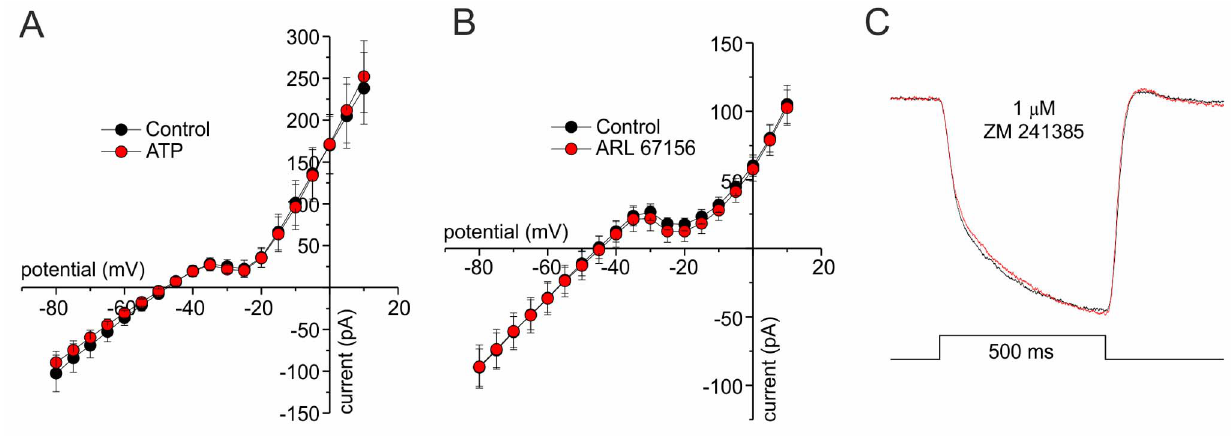
Figure 6. Purinergic receptor activation does not underlie feedback from HCs to cones. (A) A whole-cell IV relation for cones in control condition (black) and with 100 m M ATP (red; n =5). ATP does not activate a nonspecific cation conductance. (B) A whole-cell IV relation for cones in control condition (black) and 50 m M ARL67156 (red; n =5). ARL67156 did not lead to the activation of a nonspecific cation conductance. (C) Mean feedback responses in control (black) and in 1 m M ZM 241385 (red; n =4), a blocker of the A2 receptor. The response amplitude and kinetics of the feedback response were not significantly affected, indicating that feedback is not mediated by A2 receptors.